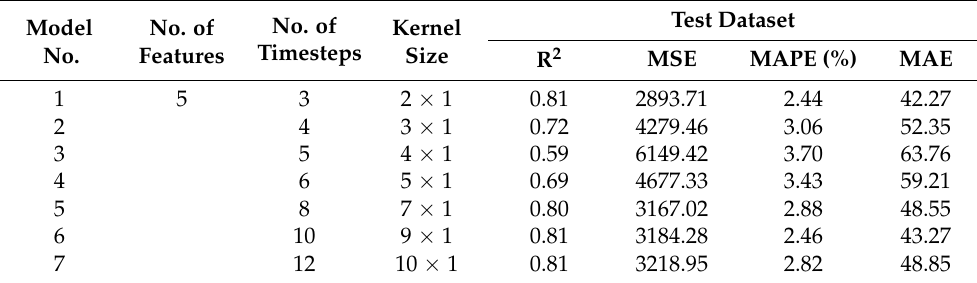
Table 8. Performance of the different multivariate CNN models proposed.